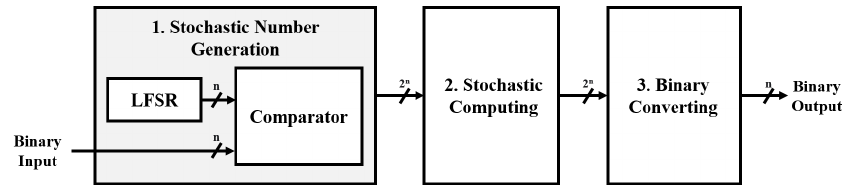
Figure 2. Flow of a stochastic